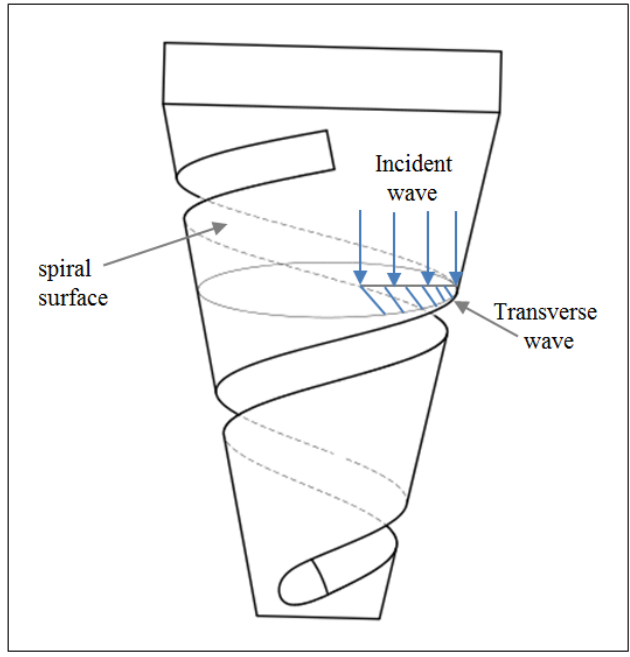
Figure 4. Schematic diagram of spiral structure. Figure 5 illustrates the front cover plate of the longitudinal–torsional transducer. Where C-D denotes the helix start line, r is the radius of the circle formed by the helix. The inner diameter and outer diameter of the front cover plate are r 1 and r 2 , respectively.